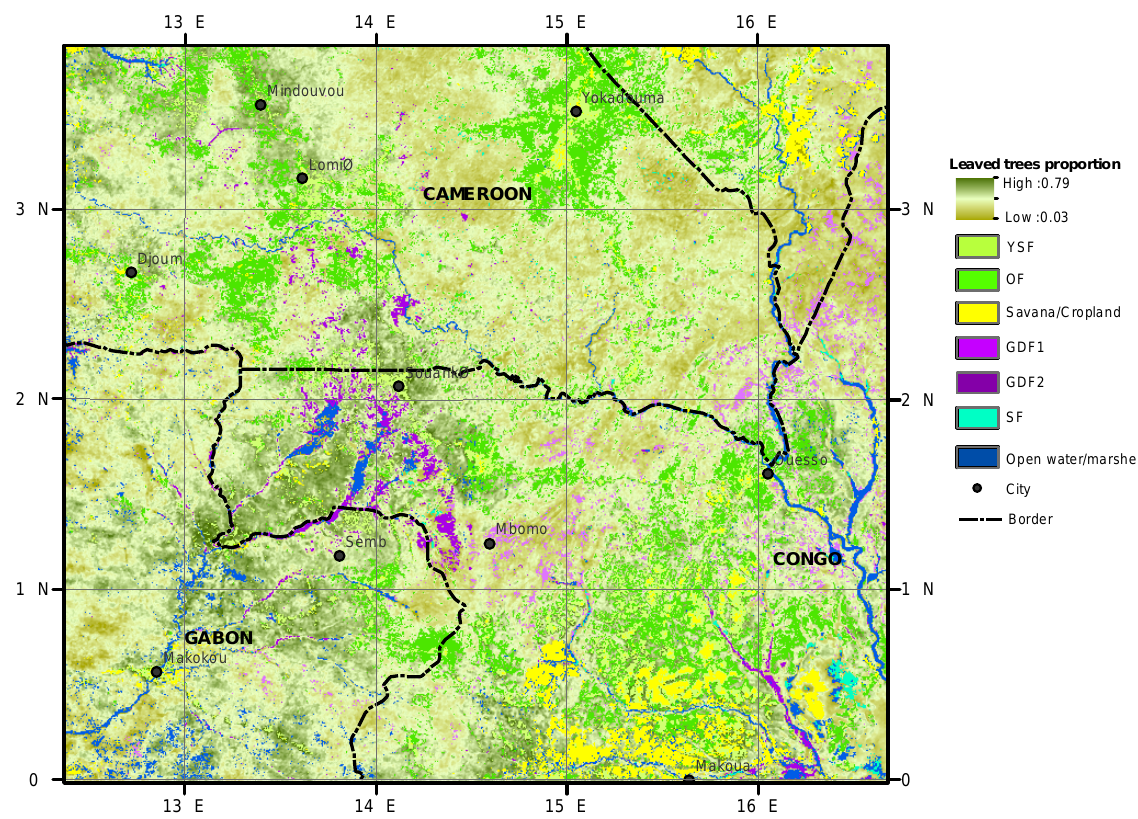
Fig. 5. Map of the distribution of the main forest classes (open forest, young secondary forest, swamp forest and monodominant Gilbertio- dendron dewevrei forests) along with the MODIS-predicted leaved trees proportion within the mixed forest class (Map Projection WGS84). The entire map was derived from remotely sensed MODIS pixels of 250m (aggregation of dry-season values). The leaved tree proportion within the MF class was predicted by linear inversion of the leafiness equation: y = 0 . 1290 x + 0 . 3, where y is dry-season EVI values aver- aged over the 2000–2011 period and x the proportion of leaved trees counted on SPOT 5 images. Abbreviations: GDF (1–2):